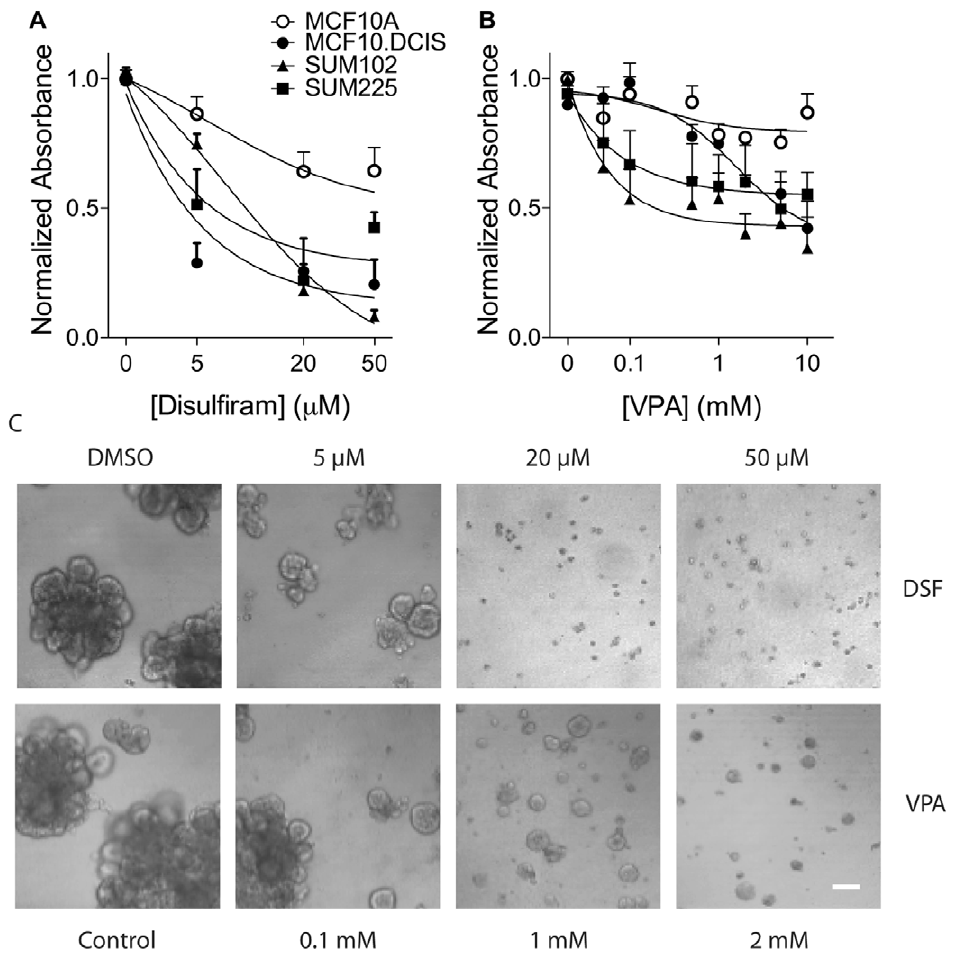
Figure 6. ALDH5A1 as a target in DCIS models. ( A, B ) Effect of DSF and VPA on proliferation of MCF10A ( open circles ), MCF10.DCIS ( closed circles ), SUM102 (triangles) and SUM225 ( squares ) 3D rBM cultures. Cells were incubated for 72 hours with the indicated concentrations of drugs or with DMSO as a vehicle control and subjected to an MTT assay. Sigmoidal dose-response curves were plotted using nonlinear regression analysis. Data represent the mean 6 SEM of three independent experiments (each performed in triplicate). ( C ) Effect of DSF and VPA on 3D rBM cultures of SUM102-mRFP cells. Cells were incubated for 8 days with the indicated concentrations of drugs or with DMSO as a vehicle control and DIC images are shown. Size bar, 90 m m.